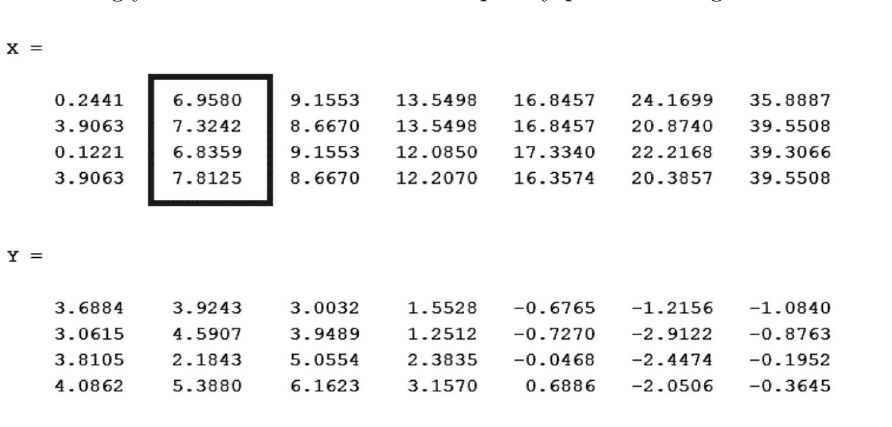
Figure 6. Matrix – low frequencies, attention disorders, sample